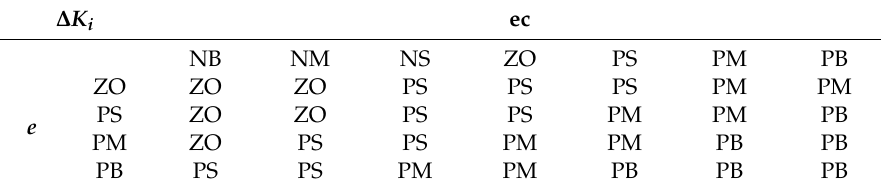
Table 5. Fuzzy rules for integral gain Δ 𝑲 𝒊 in the fuzzy control algorithm. Table 4. Fuzzy rules for proportional gain ∆ K p in the fuzzy control algorithm.